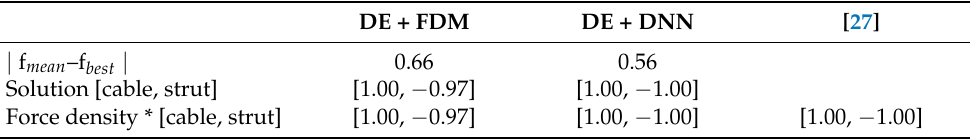
Figure 8. The final results of 2D two-strut tensegrity structure using the ( a ) FDM and ( b ) DNN-based form-finding model with DE algorithm. Table 4. The final results of the 2D two-strut tensegrity structure using the FDM and DNN-based form-finding model with the DE